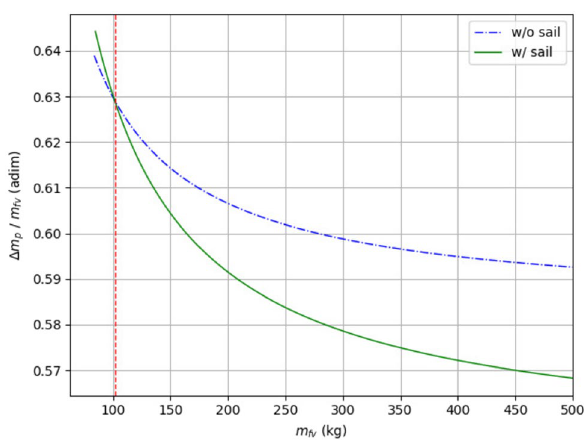
Figure 16. Normalized propellant mass variation per flight vehicle mass.